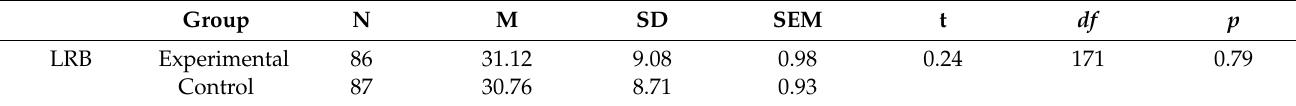
Table 2. The pre-test of experimental and control groups on LRB, CRB, and